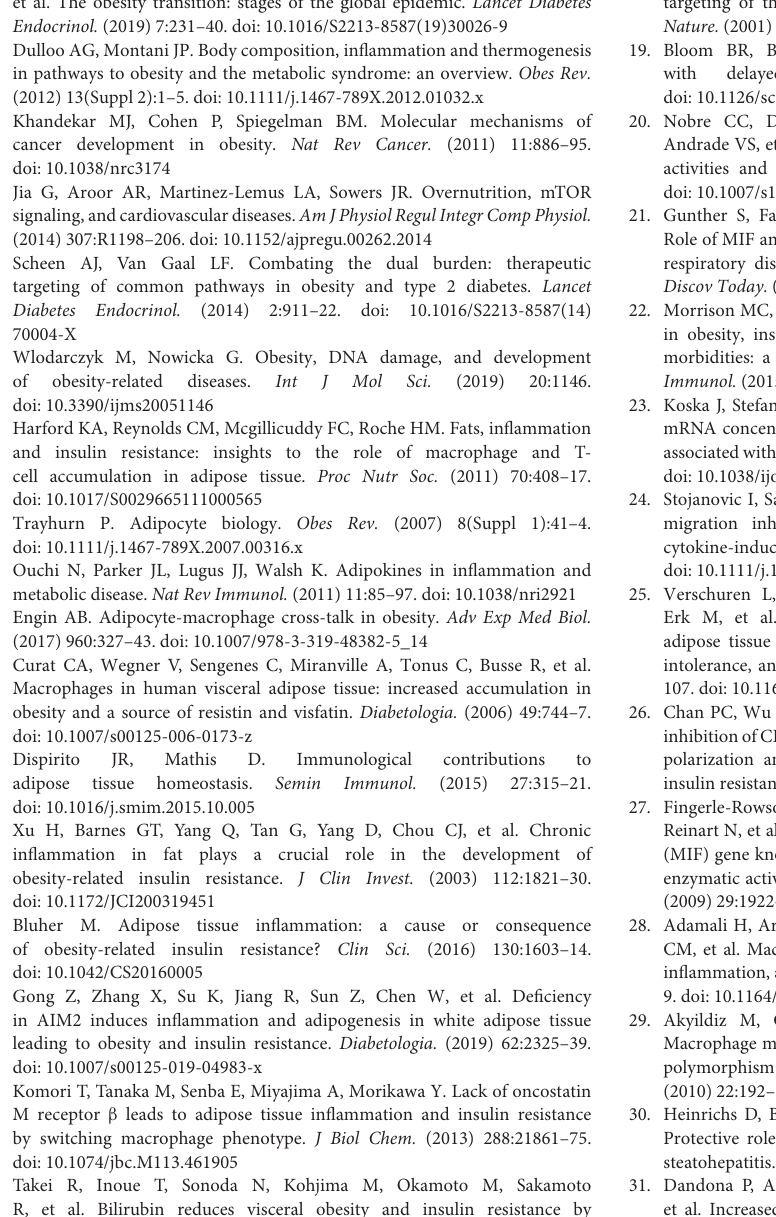
Figure S1 | The expressions of lipid metabolism related genes in MIF P1G / P1G mice and WT mice. (A) The selective knockout of tautomerase activity of MIF was validated in vitro . (B) The expressions of lipid synthesis related genes. (C) The expressions of lipolysis related genes. (D) The expressions of fatty acid oxidation